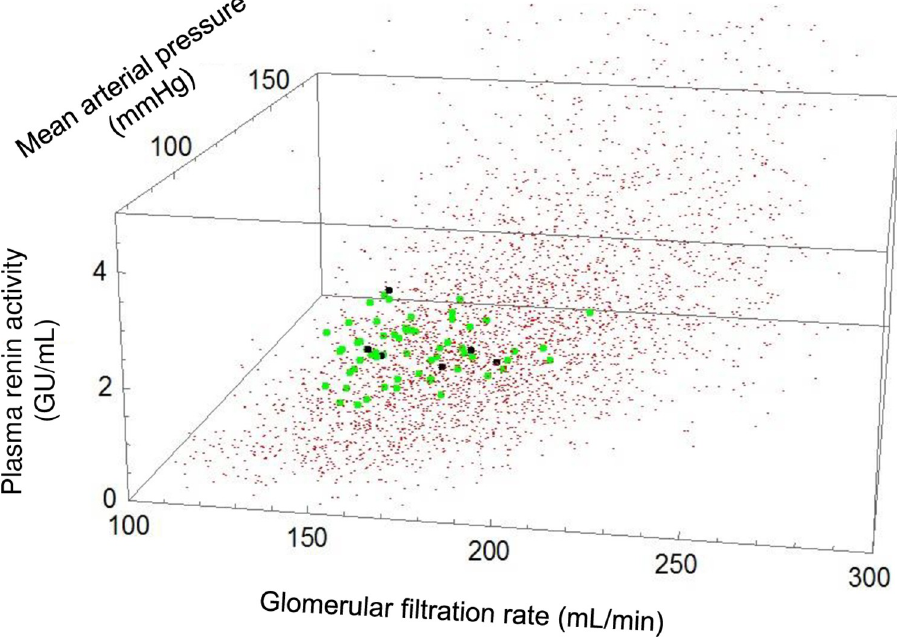
Fig 1. Baseline variables in the experimental (n = 6, shown in black from [22]) and virtual populations (both uncalibrated [n = 6,092 in red] and calibrated [n = 60, in green]) in three dimensions: Mean arterial pressure, plasma renin activity, and glomerular filtration